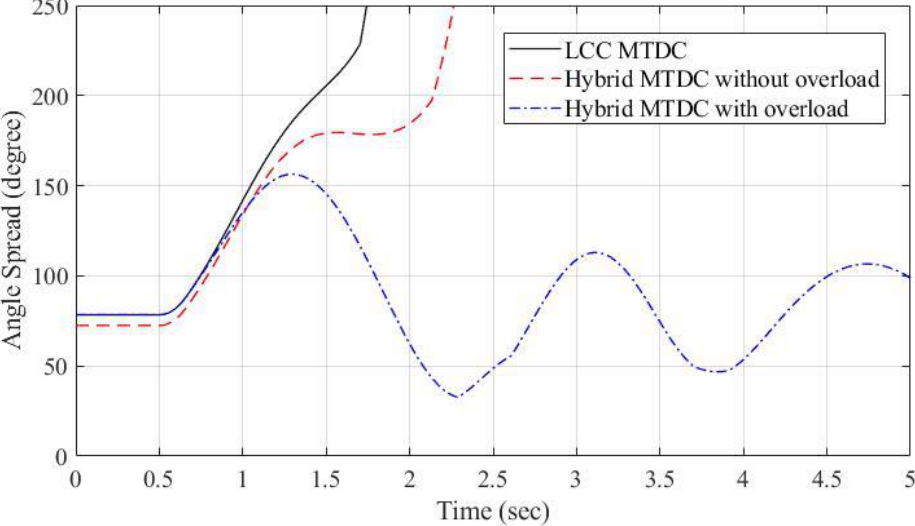
Figure 20. The angle spread from the simple overload simulation for each topology.